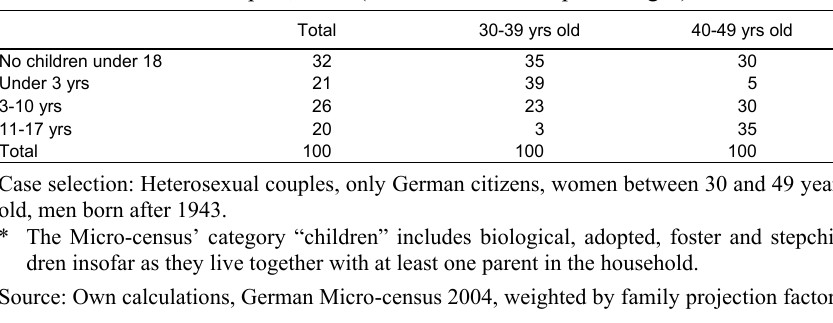
Table A4: Female employment and presence and age of underage children in aca- demic couples, 2004 (in rounded row percentages) Not employed Job Prof. occupation full-time Prof. occupation part-time No children under 18 8 22